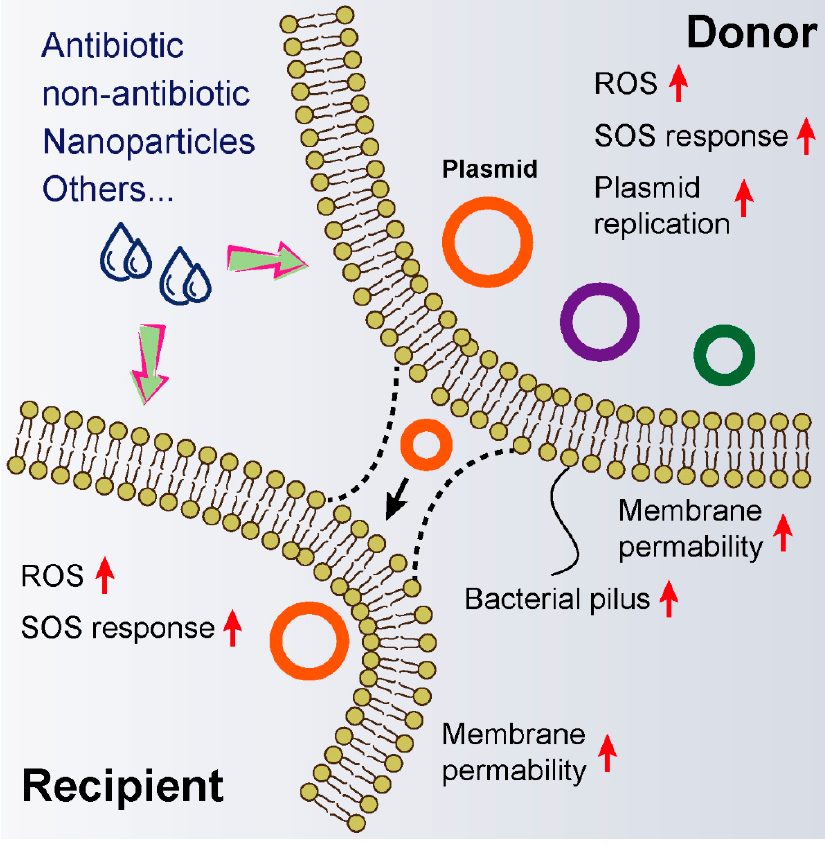
Figure 2. Schematic representation of molecular mechanisms that exogenous compounds promote—conjugative transfer of resistance plasmids. Exogenous compounds including antibiotics, non-antibiotic drugs, nanoparticles and others could promote horizontal gene transfer within or across bacterial genera through triggering the production of ROS, inducing SOS response, enhancing membrane permeability, increasing bacterial pilus generation and promoting plasmid replication.